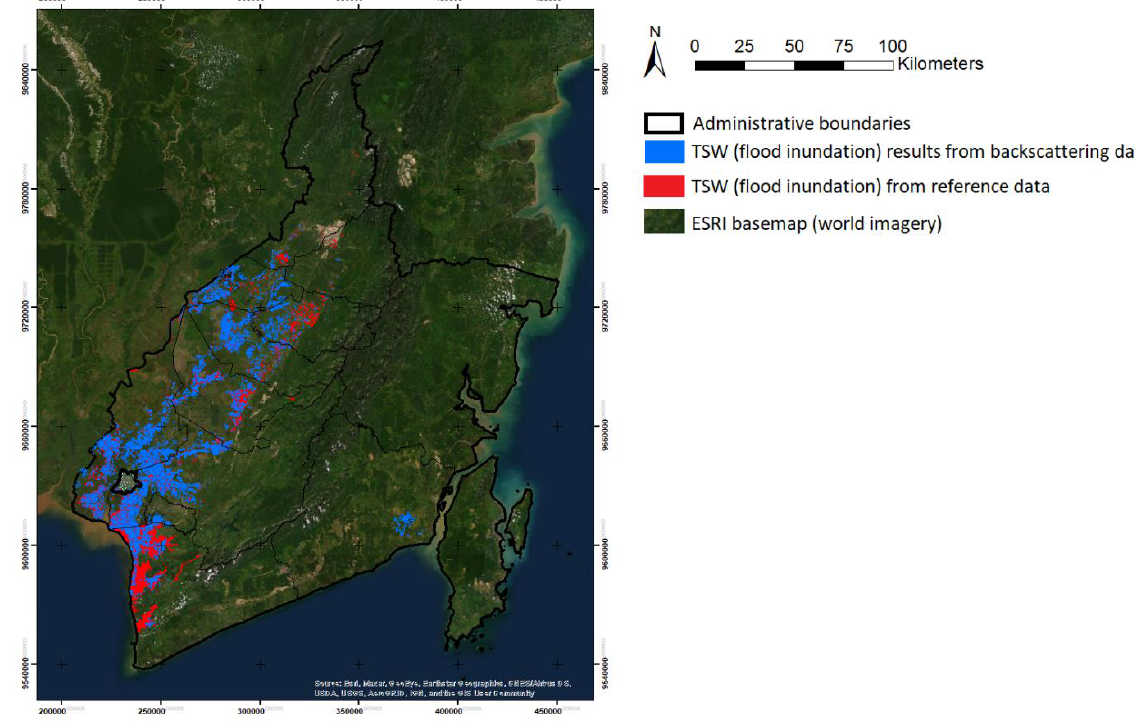
Figure 4 . Comparison of Temporary Surface Water (TSW) Result from Backscattering Data with Reference